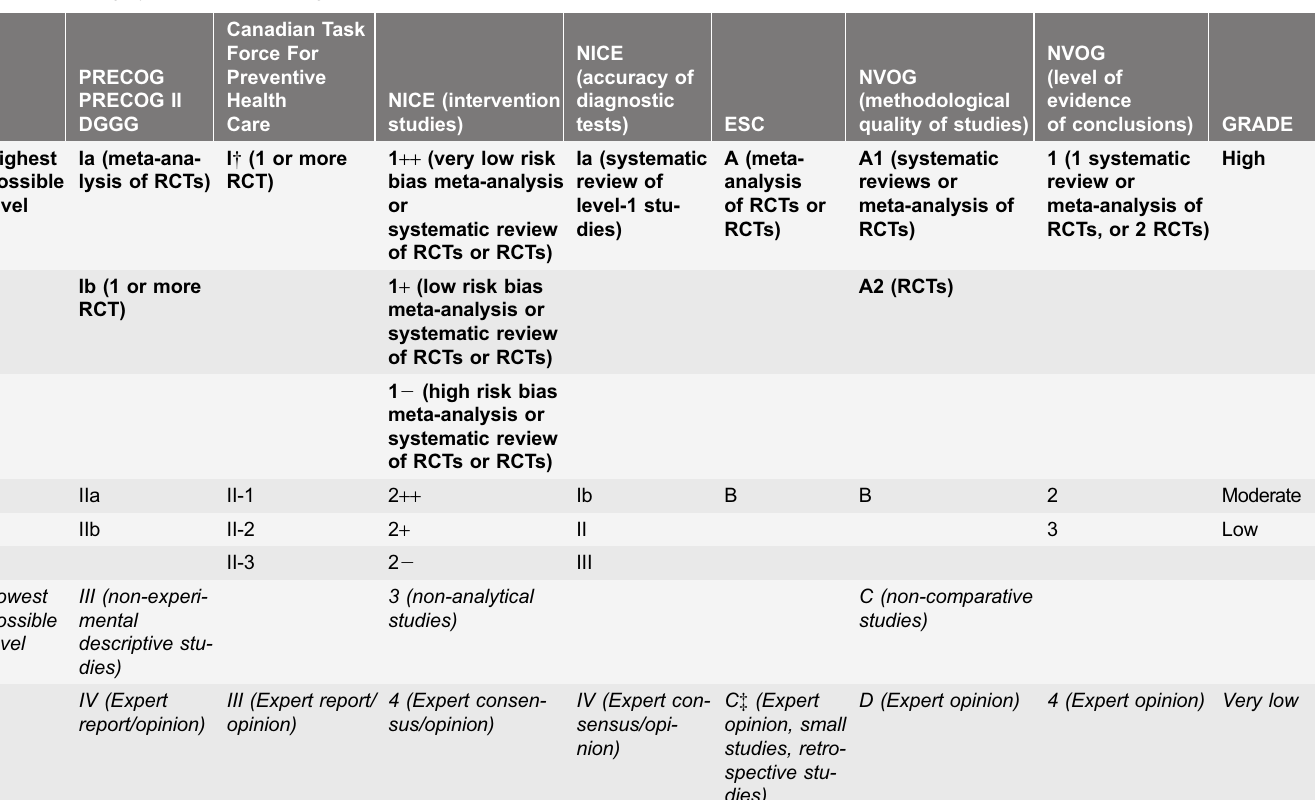
Table 2. Grading systems for assessing the levels of evidence*.